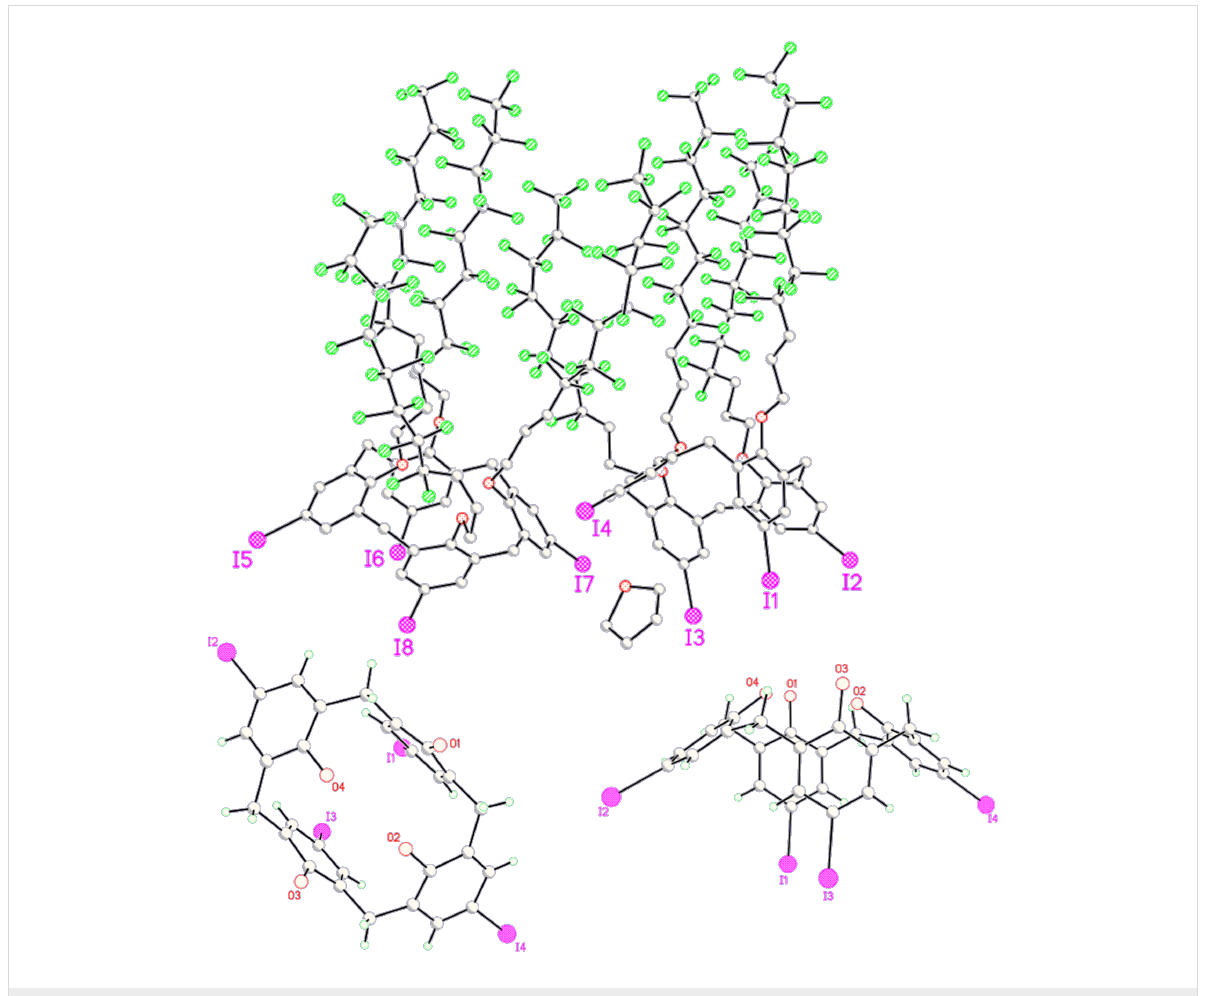
Figure 2: Full (top), top (bottom left) a , and side (bottom right) a views of 5 ; a fluorous chains omitted for clarity.